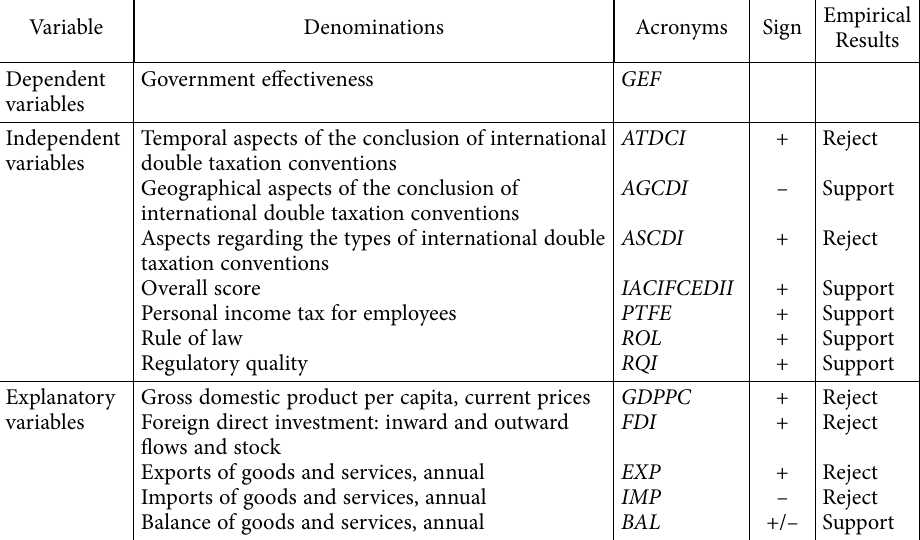
Table 16. Derived signs of the independent and explanatory variables in equation and validation by the empirical results – Eq. (3) (source: own processing) Variable